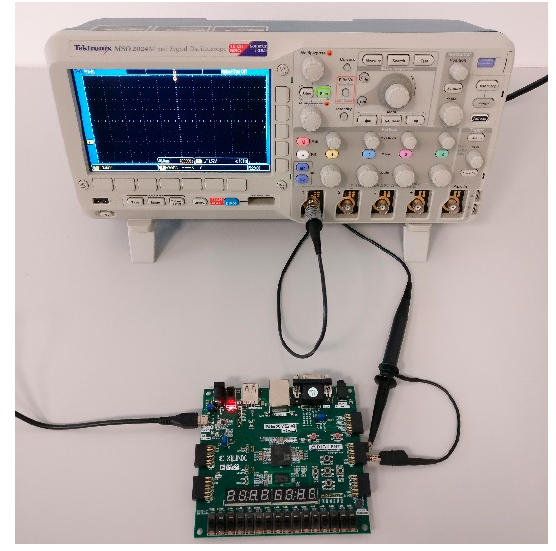
Figure 7. Experimental setup for the hardware measurement.